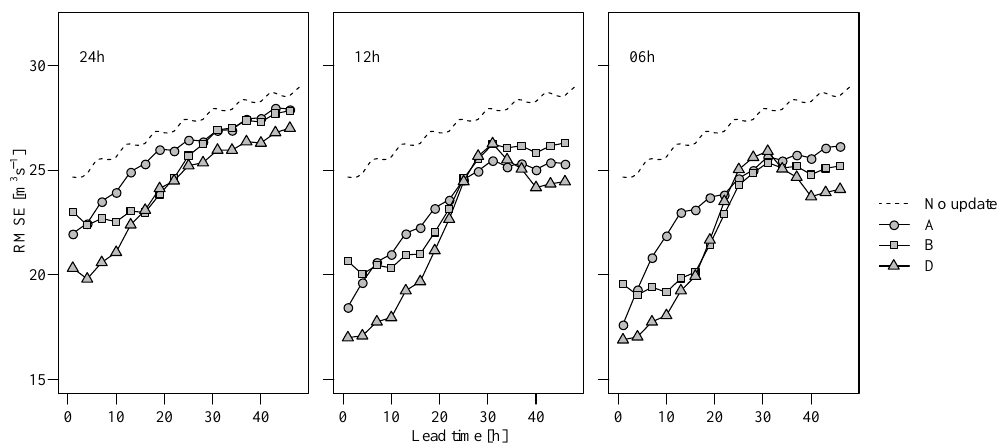
Fig. 9. Same as Fig. 8, but for simulation period from 27 December 2002 to 8 January 2003.